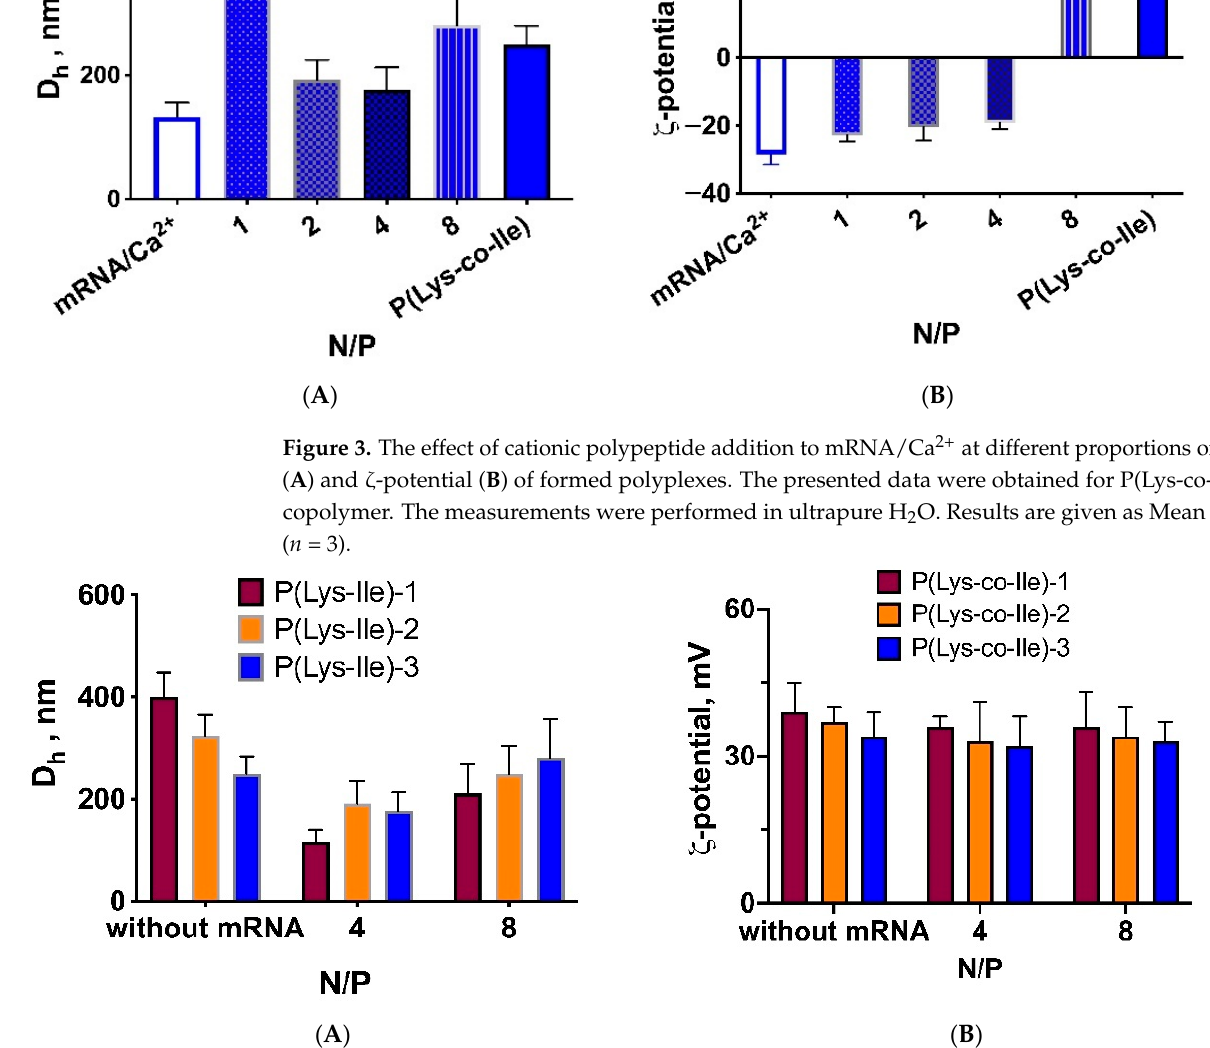
Figure 4. Hydrodynamic diameter ( A ) and ζ -potential ( B ) of cationic polypeptides and polyplexes obtained under the 30 s ultrasonication (10% power from 70 W, 0.21 kJ) during mRNA/Ca 2+ encap- sulation. The measurements were performed in ultrapure H 2 O. Results are given as Mean ± SD ( n = 3).